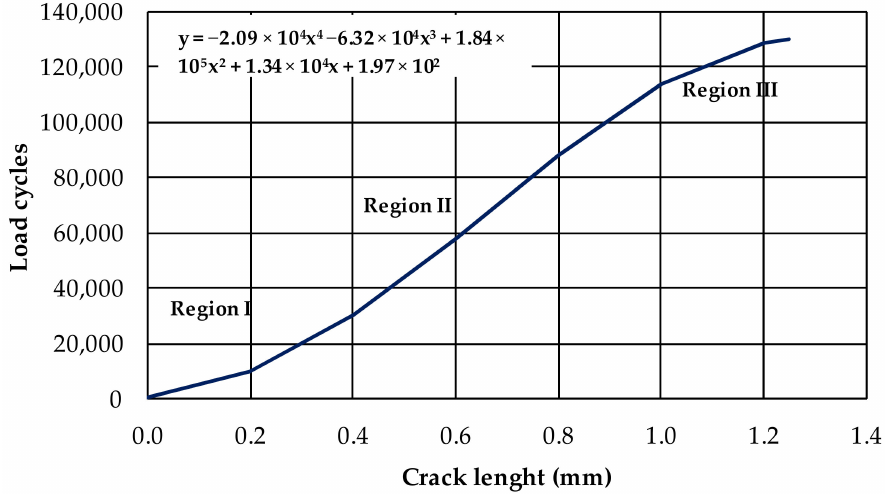
Figure 10. Crack opening concerning the load cycles in RCD tests.